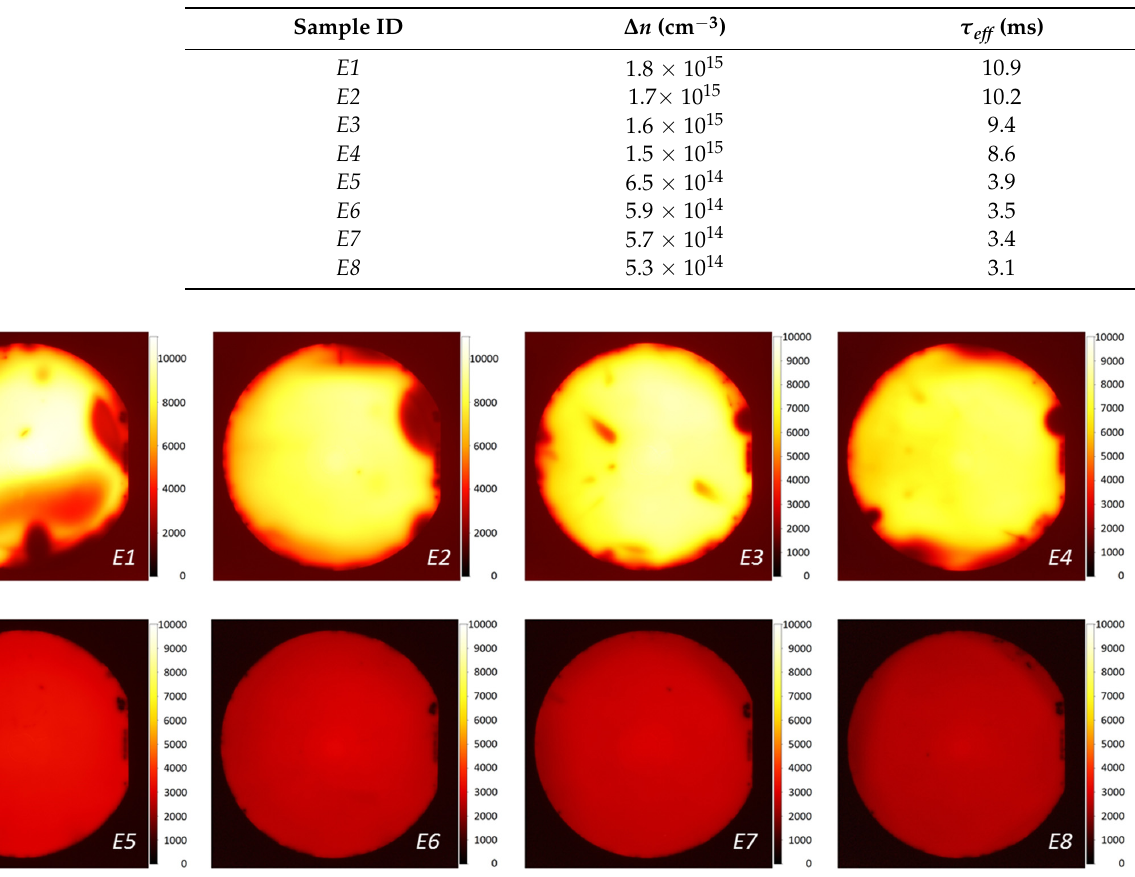
Figure 9. Photoluminescence (PL) lifetime images of samples prepared with the passivation processes described in Table 1. The color bar shows τ eff in µs.